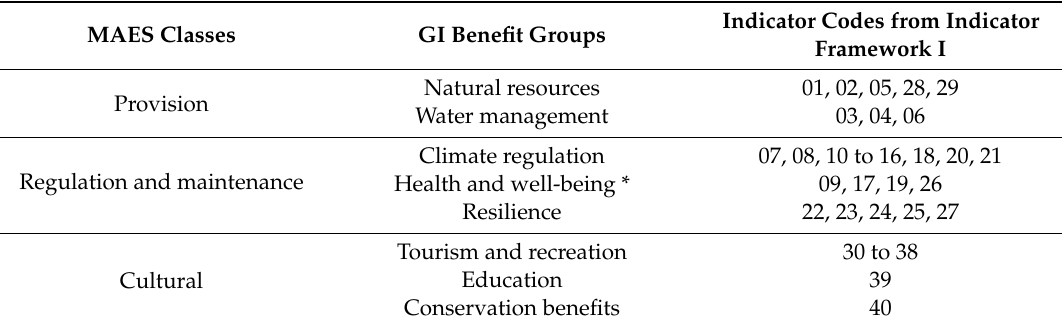
Table 1. Transformation of the structure of Indicator Framework I from Mapping and Assessment Ecosystem Services (MAES) into ten GI benefit groups (Indicator codes refer to Table